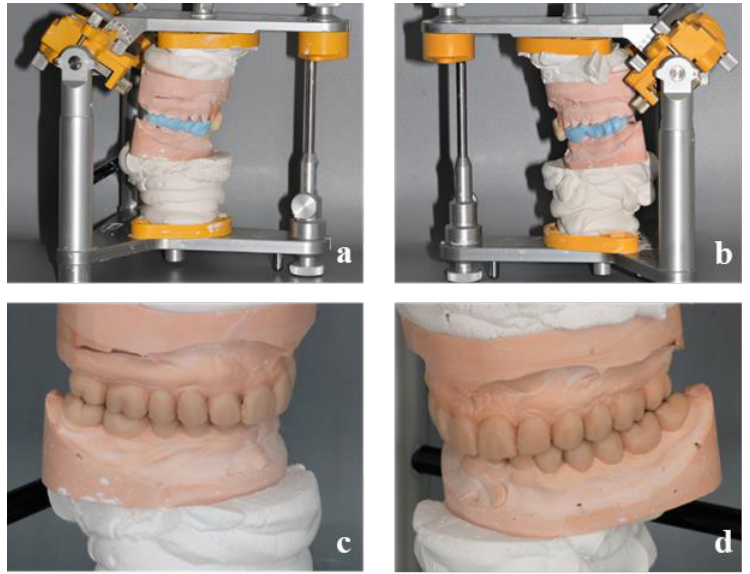
Figure 4. Placement in articulator of the models using the Lucia Jig and an occlusal bite ( a , b ) and wax-up of the models in the new vertical dimension of occlusion ( c , d ).